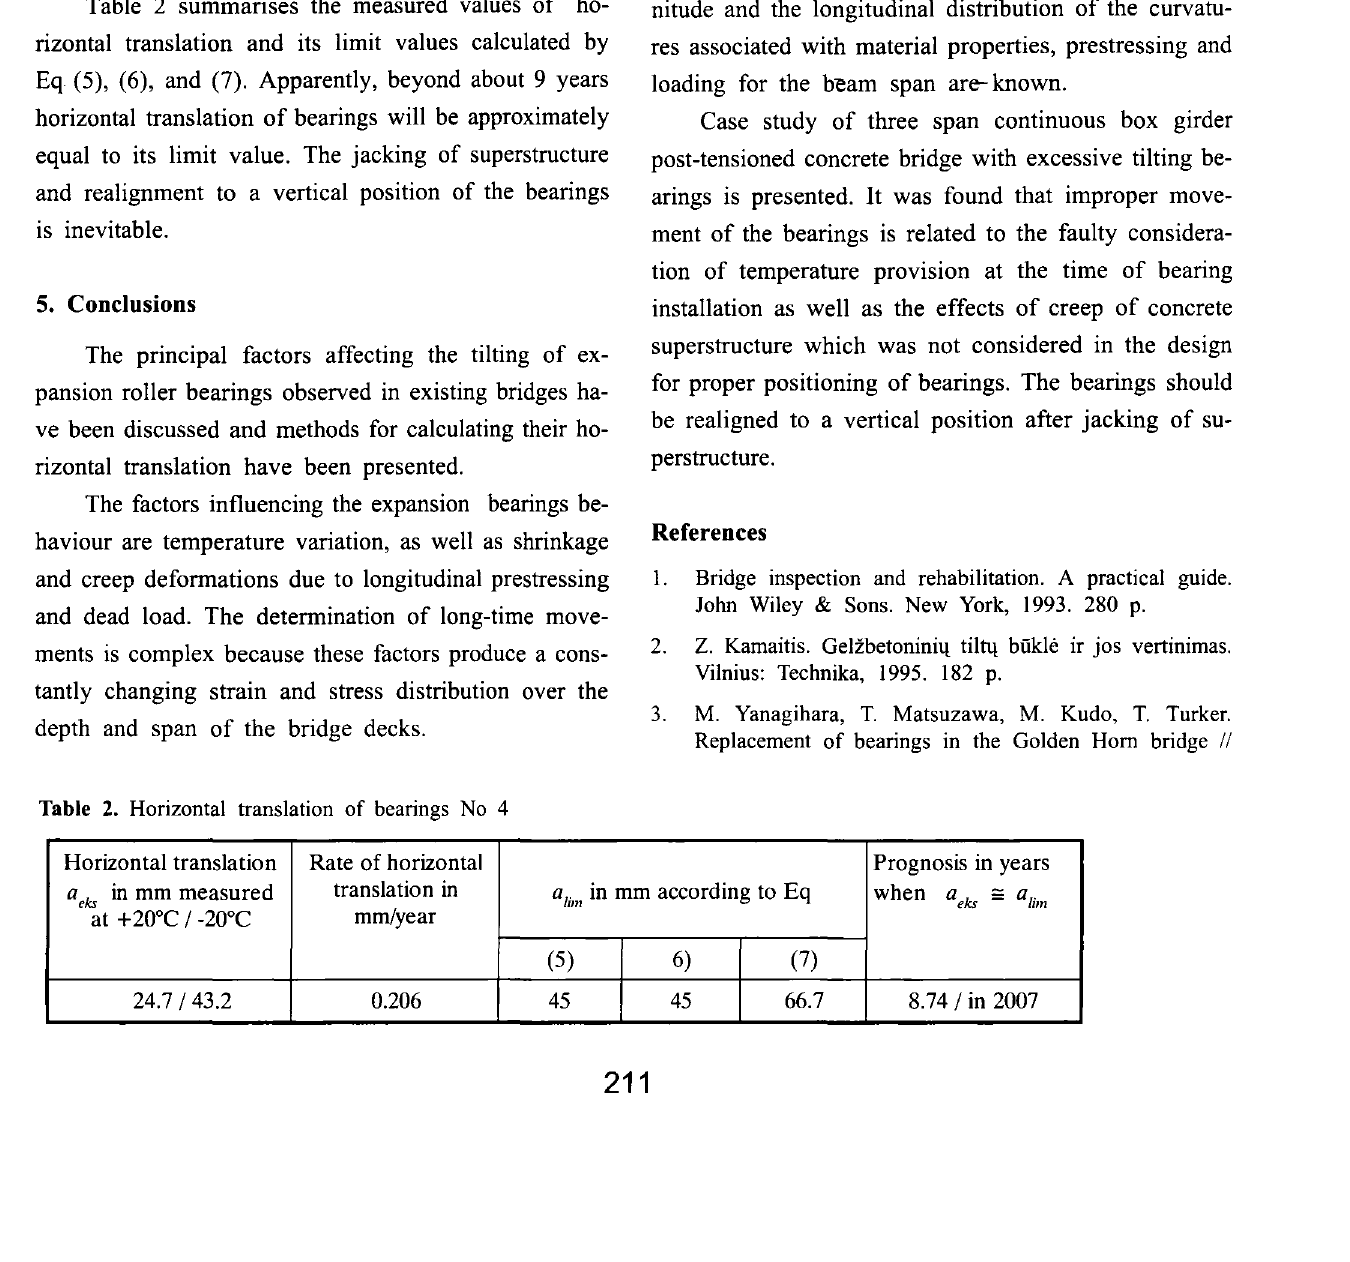
Fig 4. Deflection diagram and rotation of the sections adjacent to supports No 4 and No 3